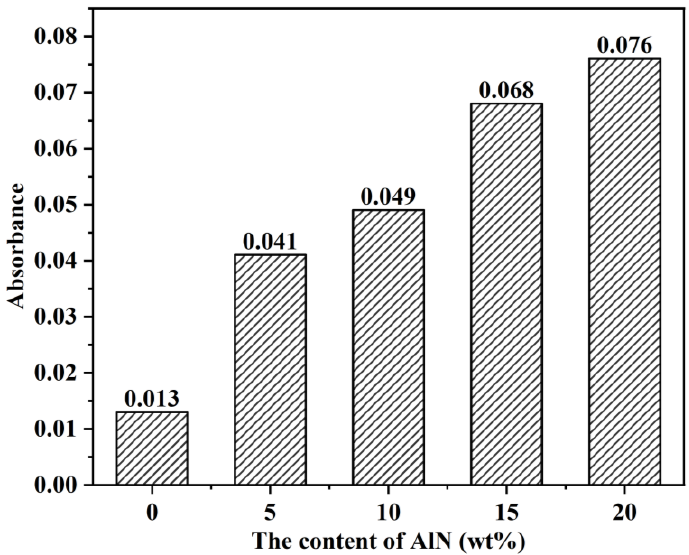
Figure 4. The absorbance of the Al 2 O 3 -AlN powders with 0 – 20 wt% AlN at 405 nm wavelength.